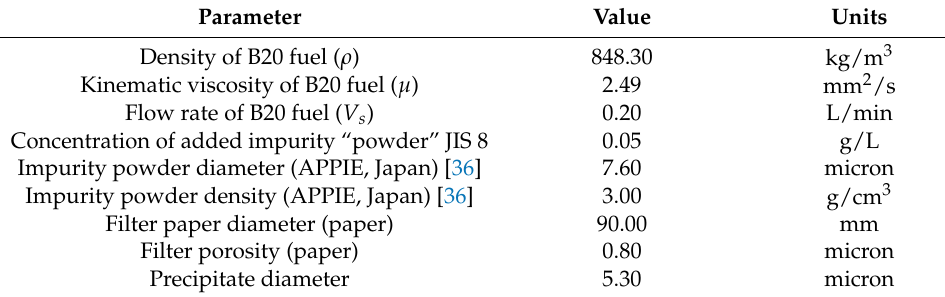
Table 1. Specification of parameters stated in Ergun